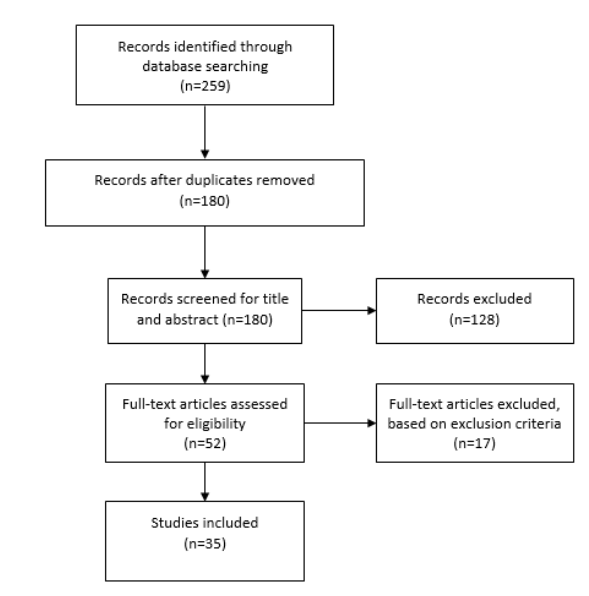
Figure 1. Literature search flow